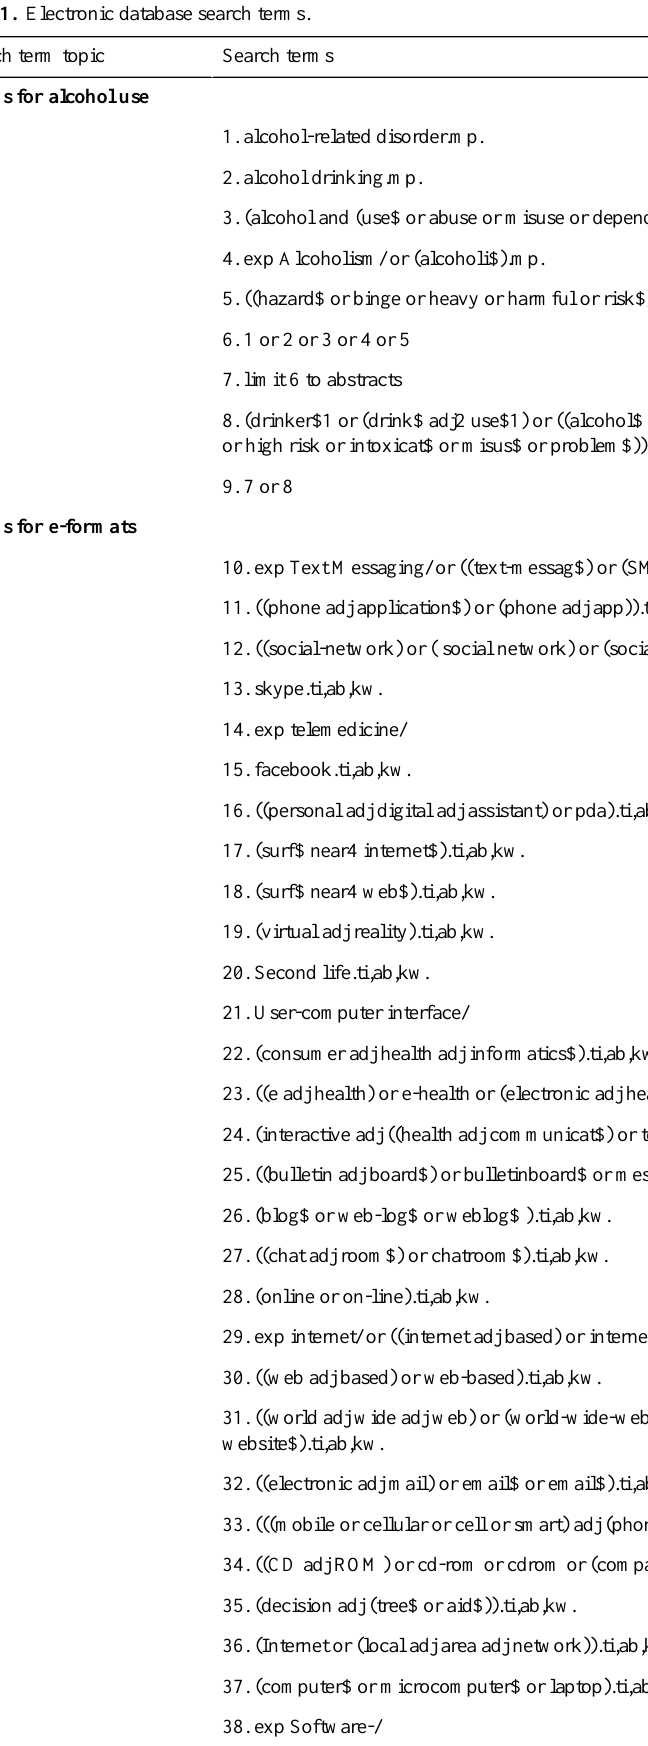
Table 1. Electronic database search terms.